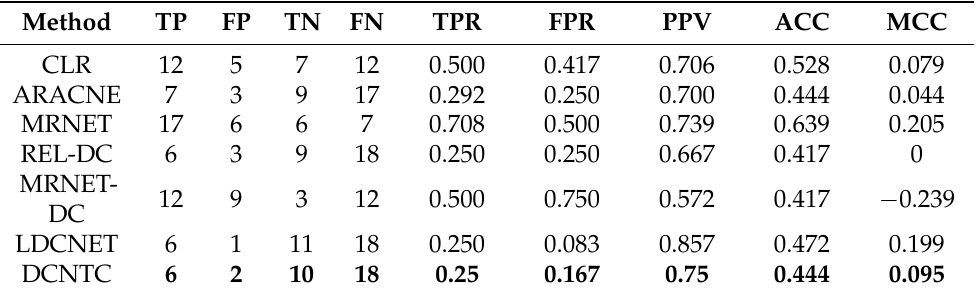
Table 4. Comparison of different methods on the SOS DNA repair